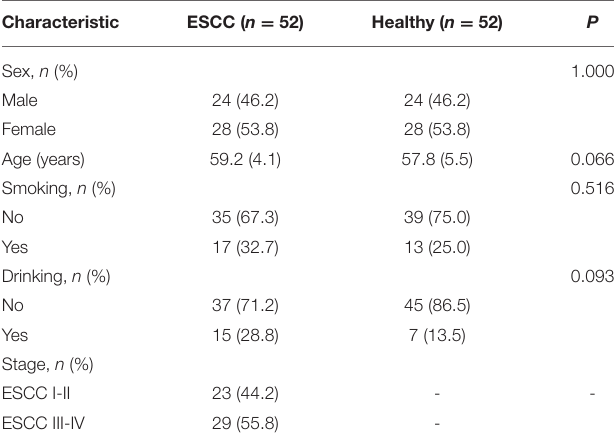
TABLE 1 | Characteristics of the study